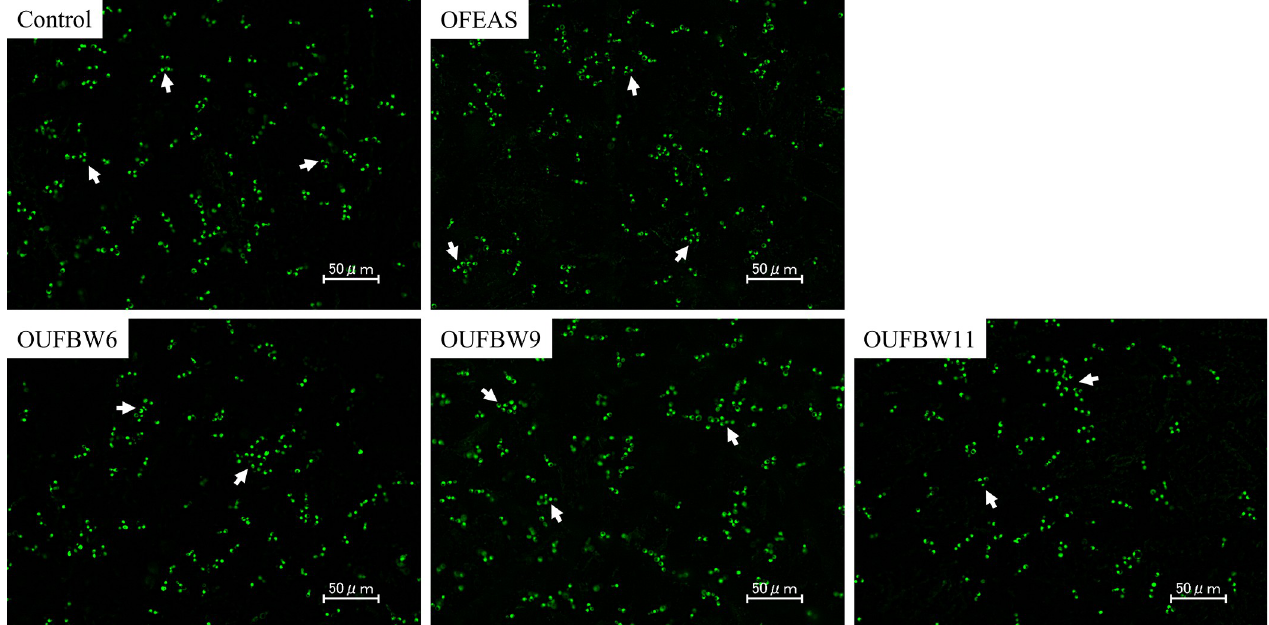
Fig 3. Fluorescence microscope image of Candida on PMMA. Green fluorescence indicates live cells, and red fluorescence indicates dead cells. No dead cells were observed in all samples regardless of the increase of ozone concentration.